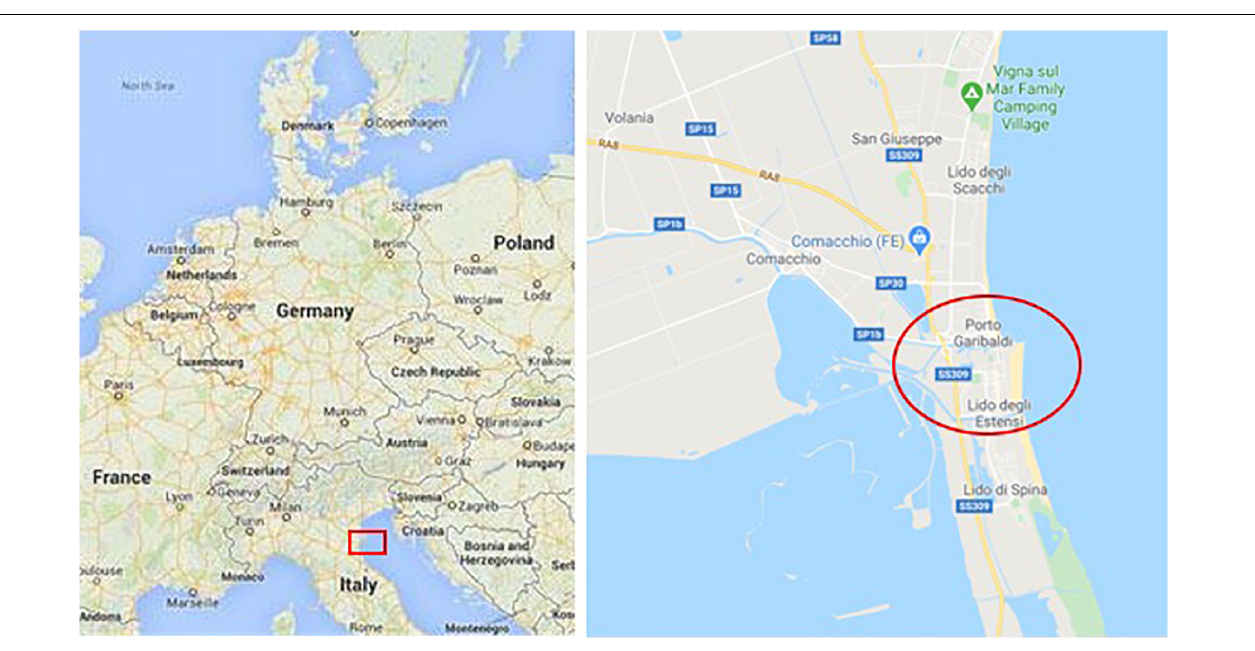
FIGURE 3 | Map of Porto Garibaldi. Source: Created by using map data © 2020